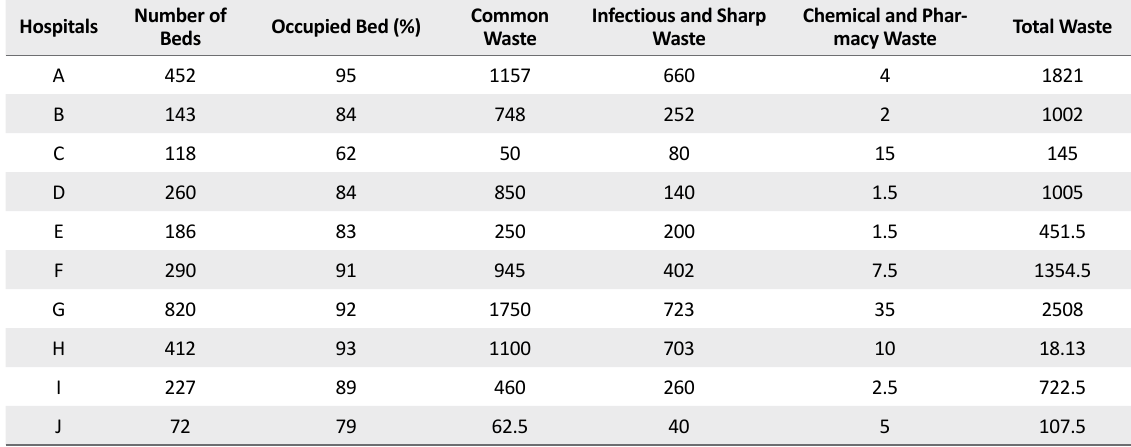
Table 1. Quantity and composition of medical wastes in hospitals studied (kg/bed/day)